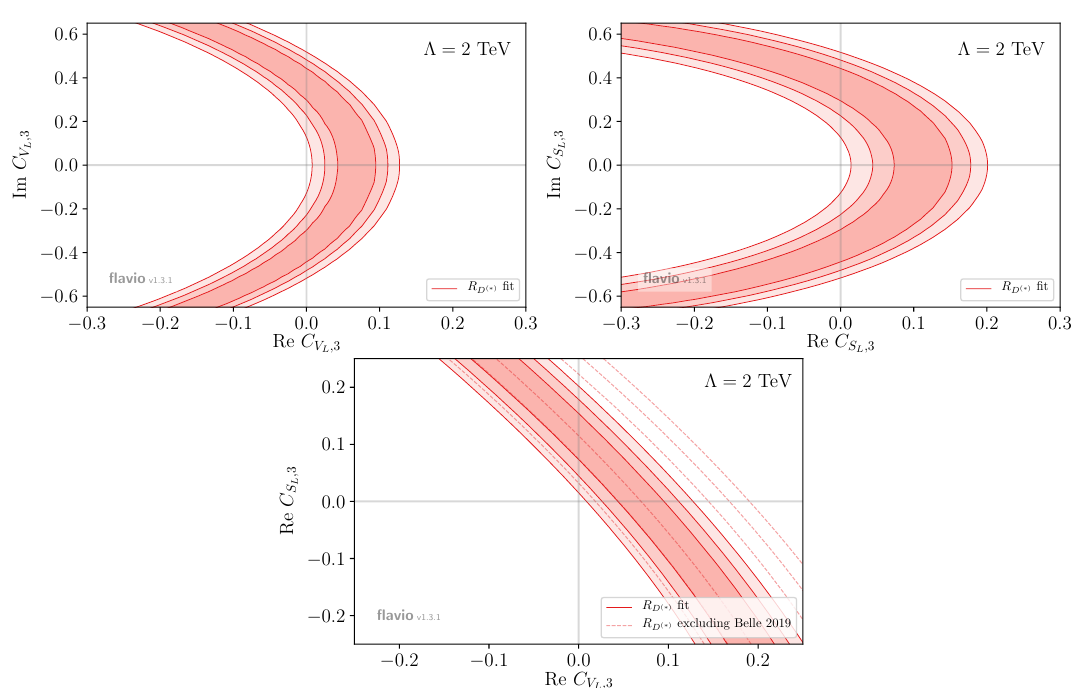
| | with all other operator coe(cid:14)cients L ((cid:3)) = (cid:0) 4 C T ((cid:3)) for (cid:3) = 2 TeV and all other L and Re C S ((cid:3)) = L L